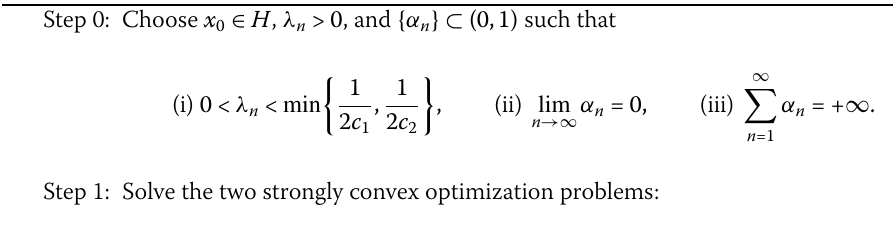
Algorithm 1.2: Halpern-type subgradient extragradient